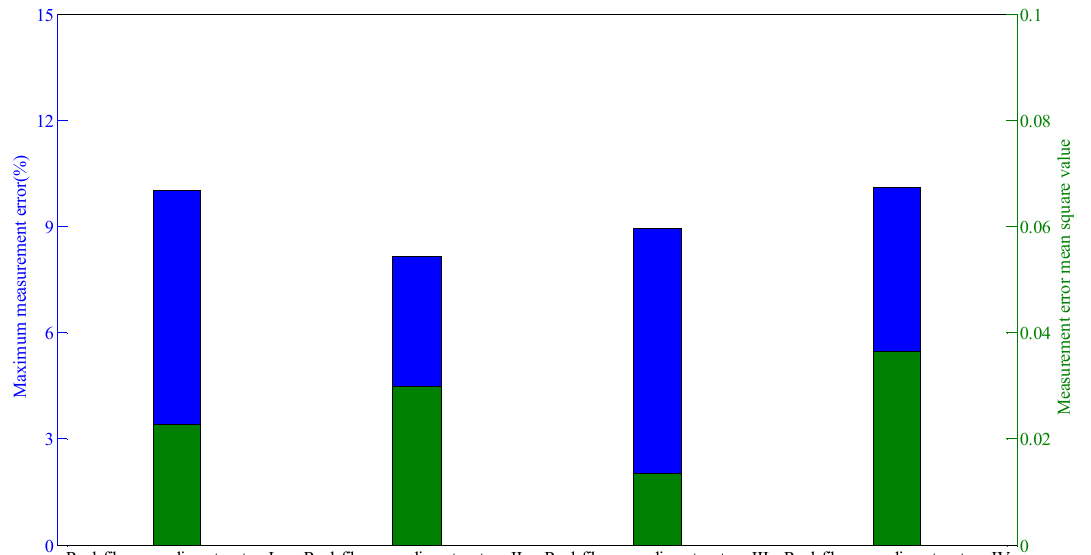
Figure 15. Measurement error mean square value and maximum measurement error of rod-fiber coupling structures I, II, Ш , and IV.